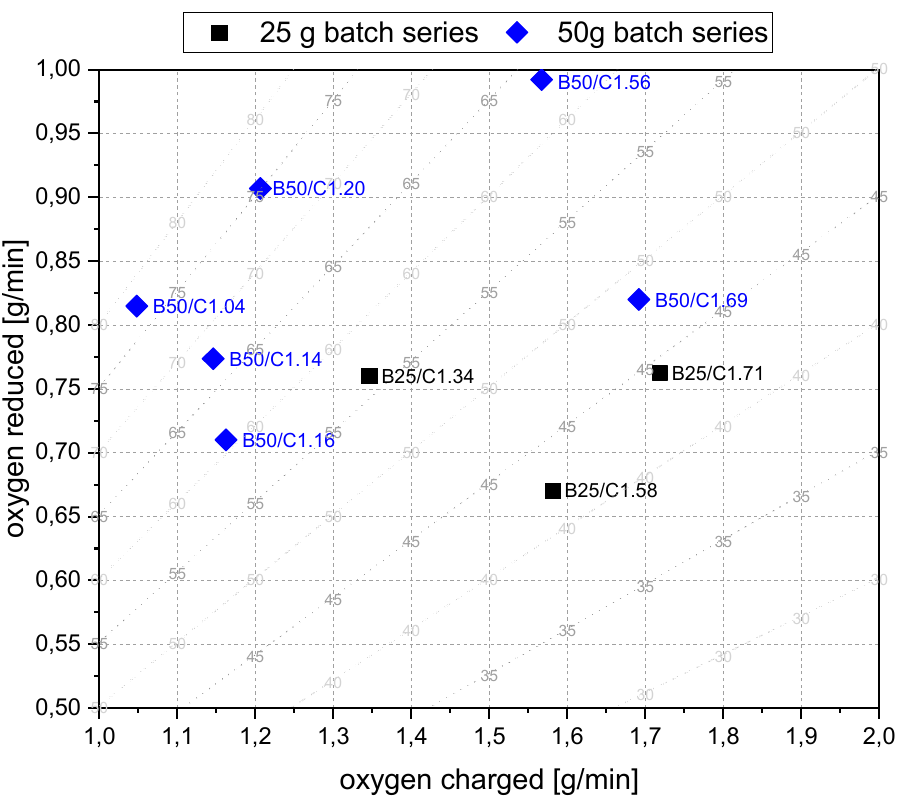
Figure 18. Comparison of the calculated oxygen removed via the oxygen supplied by the ore. Dashed lines in the background symbolize the equilibrium RED at infinite charging time. Table 8. Comparison of evaluated rates for oxygen removal of all conducted trials.